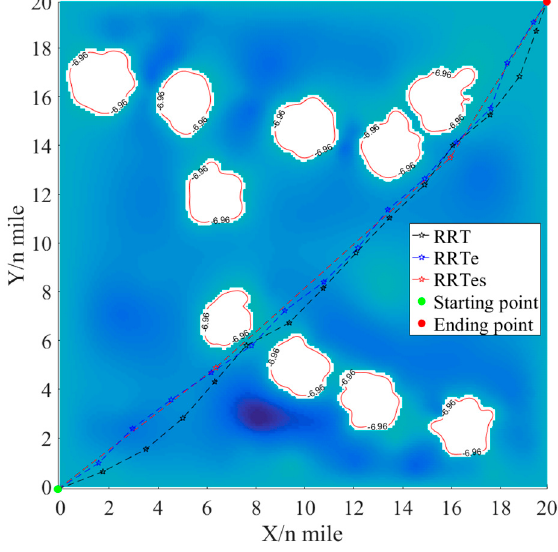
Figure 11. The shortest distance from the three global path planning algorithms (50 iterations).